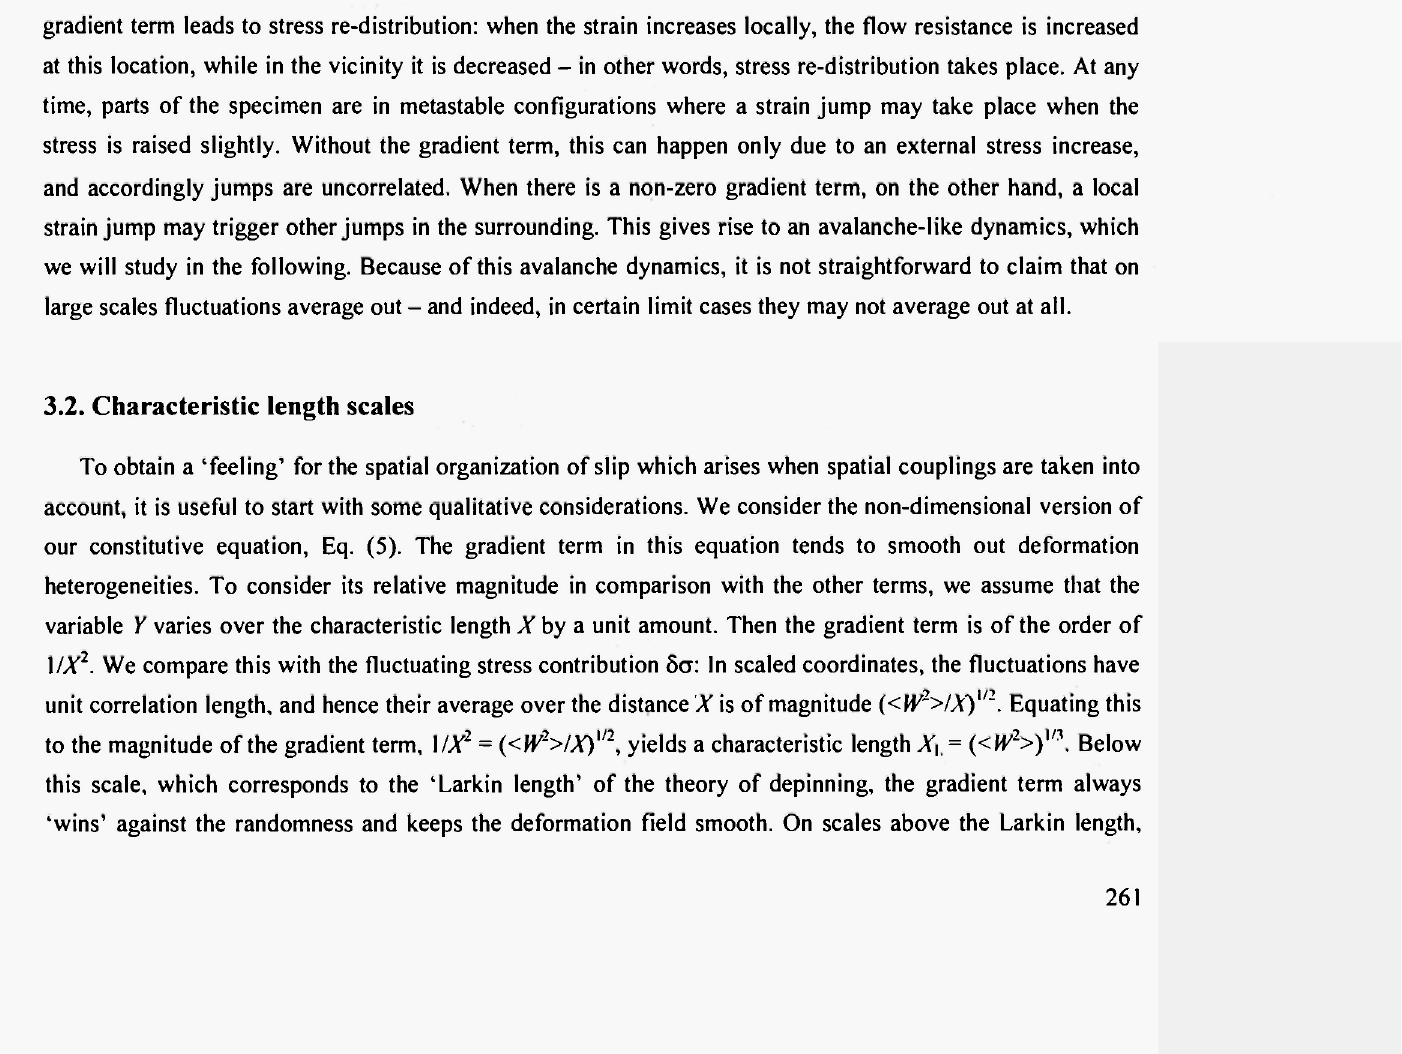
Fig. 4: Local stress-strain characteristics with illustration of some notations introduced in the text: random fluctuations of the flow resistance with amplitude <δσ 2 > are superimposed on a linear hardening with slope Θ; the dotted lines illustrate the 'jumps' which may occur when the system enters a local softening